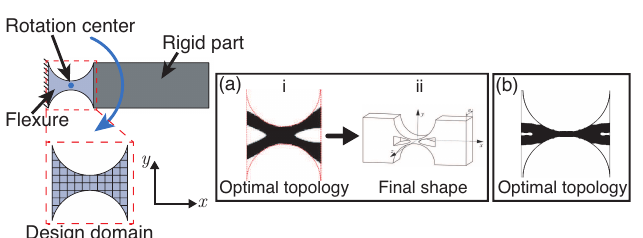
Figure 14. Schematic description of the Topology Optimization process to design the optimal configuration of SARFJ using a 2D design domain based on the geometry of a right circular flexure hinge. Optimal designs obtained: ( a ) i-optimal topology and ii-final shape (Adapted with permission from ref. [215]. 2021, Elsevier) and ( b ) optimal topology obtained in [209] (Adapted from ref. [209]. 2019, Springer).